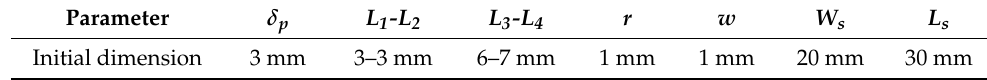
Table 1. Initial dimensions of sensitization structure.